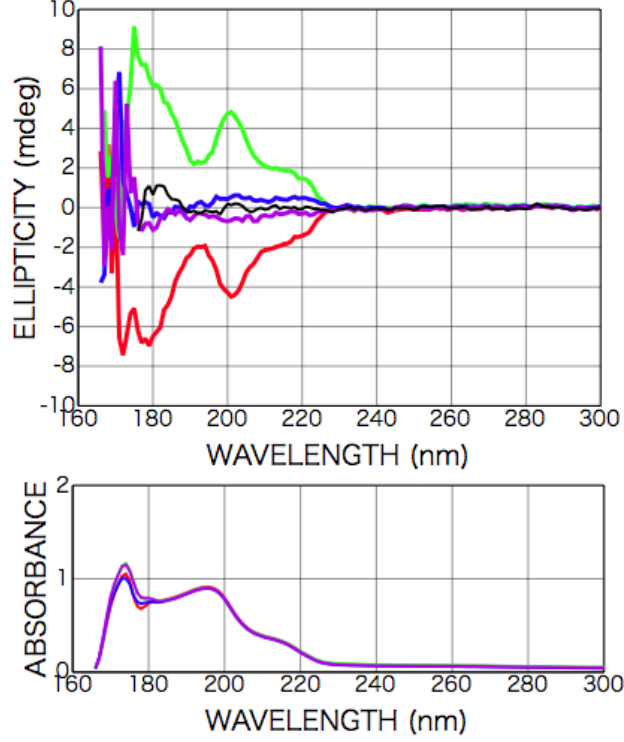
Figure 3. CD and photo absorption spectra of DL -phenylalanine film (100-nm in thickness); as deposited (black) and after LPL irradiation (cloured). The sample rotation angle θ = 82 deg. (red), θ = 127 deg. (purple), θ = 142 deg. (blue), and θ = 187 deg. (green).